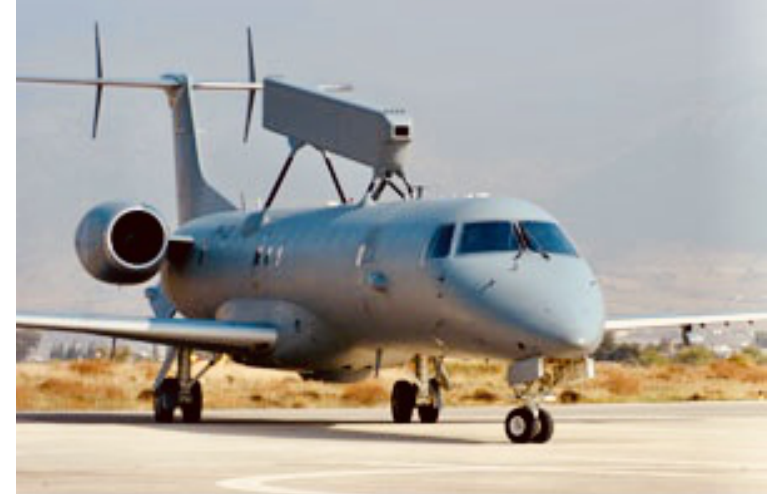
Figure 1. HAF EMB-145 AEW&C [11].